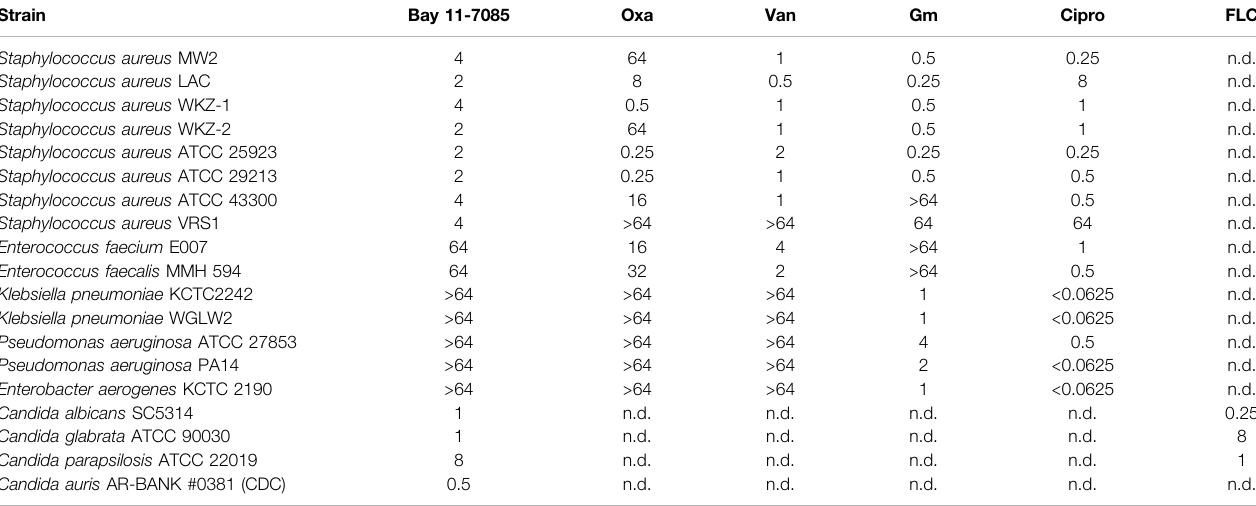
TABLE 1 | Minimum inhibitory concentrations (µg/ml) of Bay 11-7085 and conventional antibiotics against various pathogenic strains.